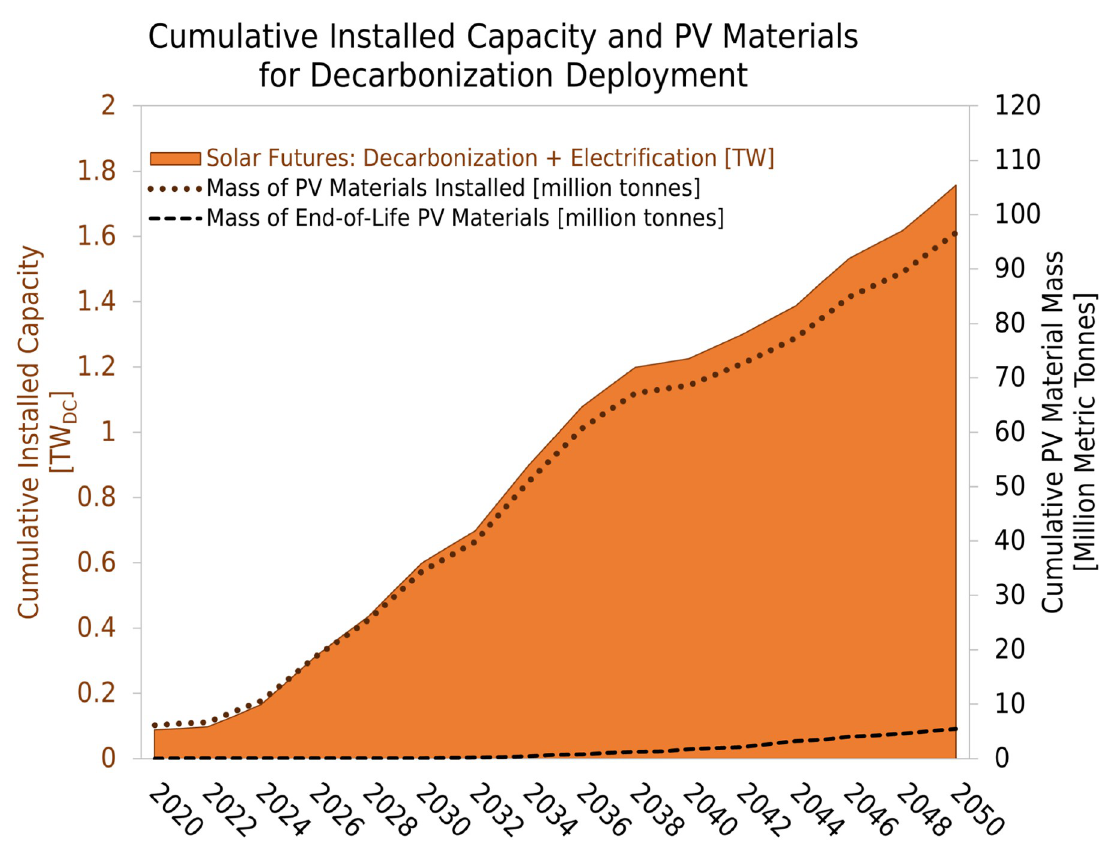
Fig 1. Installations, virgin material demands, and waste projection. Installation projections for photovoltaics (PV) in TW DC as predicted in the Solar Futures Decarbonization + Electrification scenario [3] (left axis) for this US case study. The dotted line shows the cumulative mass of PV materials deployed (right axis). The black dashed line shows the cumulative PV end-of-life material projection through 2050 based on historical and expected technology trends as captured in the PV in circular economy tool (PV ICE) baseline (right axis). The Decarbonization + Electrification scenario relies on a least-cost optimization model to meet targets, resulting in a variable deployment rate [8].